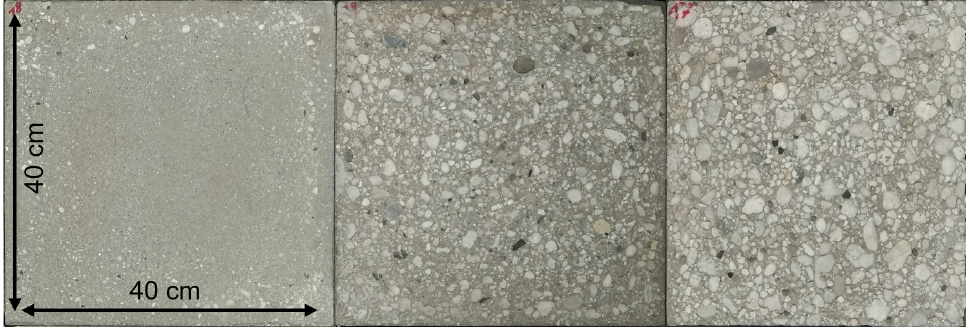
Figure 15. Selection of three concrete specimens with different roughness of the investigated 18.